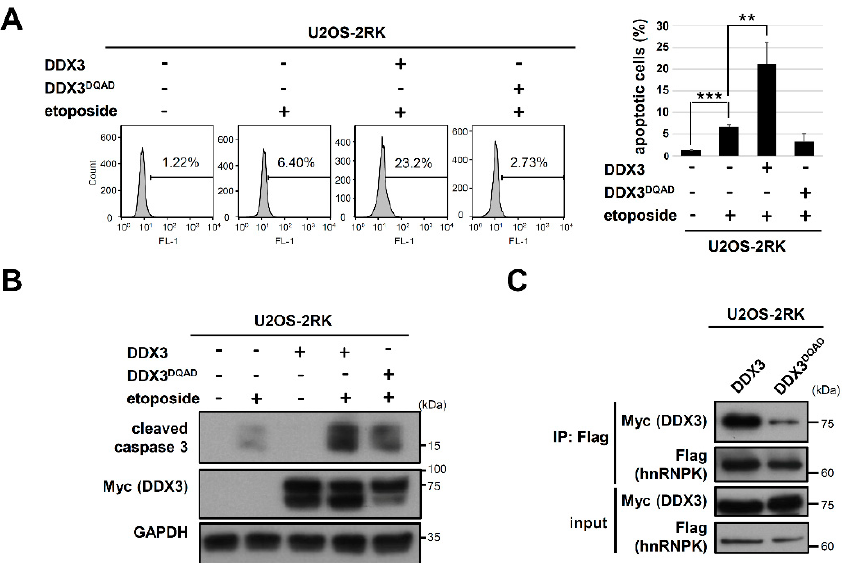
Figure 5. The helicase-inactive DDX3 DQAD reduces hnRNPK MD -mediated apoptosis by impairing hnRNPK–DDX3 interaction. ( A ) U2OS-2RK cells were transfected with either pcDNA4, Myc-DDX3, or Myc-DDX3 DQAD for 24 h followed by etoposide (50 µ M) treatment for another 12 h. Cell lysates were collected and analyzed by TUNEL assay to determine the degree of apoptosis using FACS (left). Quantitation of apoptotic cells in the TUNEL assay is shown (right). ( B ) Under the same treatment as described above, cell lysates were collected and analyzed by Western blot to determine the expression levels of cleaved caspase-3, DDX3, and GAPDH. ( C ) U2OS-2RK cells were, respectively transfected with either Myc-DDX3 or Myc-DDX3 DQAD for 36 h followed by immunoprecipitation of hnRNPK-2RK. Subsequent detection of the precipitated Myc-DDX3 or Myc-DDX3 DQAD by hnRNPK was performed. ** as p < 0.01, *** as p < 0.001.